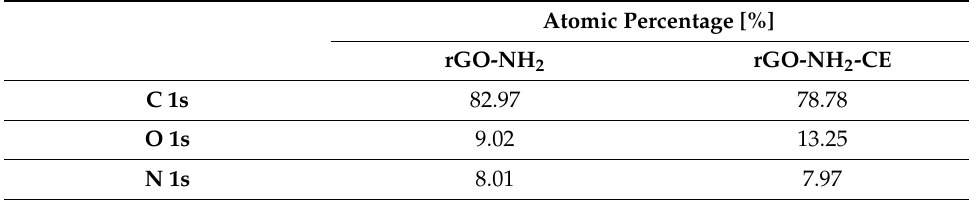
Table 2. XPS atomic percentages of rGO before and after functionalization with